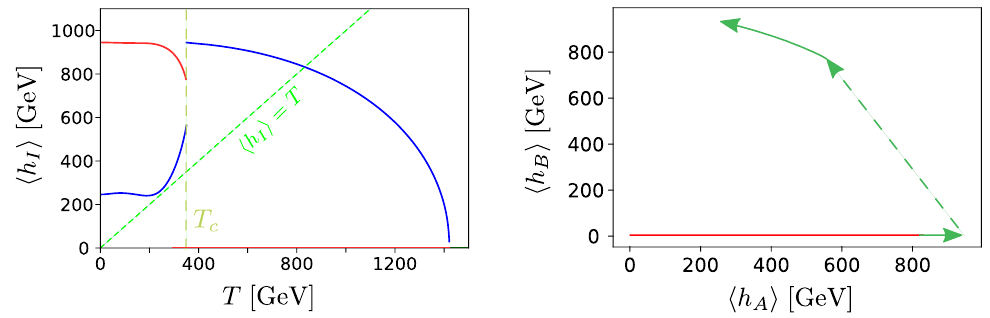
Figure 7. Left plot: h A ( T ) (blue line) and h B ( T ) (red line) VEVs during thermal evolution. Right plot: path in the h h A i − h h B i space with the part of curve where SM sphalerons are suppressed (i.e. v A ( T ) /T > 1 ) marked in green. The plots were completed at the test point ˜ y l = 2 . 7 , tan β = 0 . 8 , µ sl = ˆ µ sl = 100 GeV placed in the green region in figure 6. Baryon asymmetry wash-out does not occur below T ≈ 800 GeV.